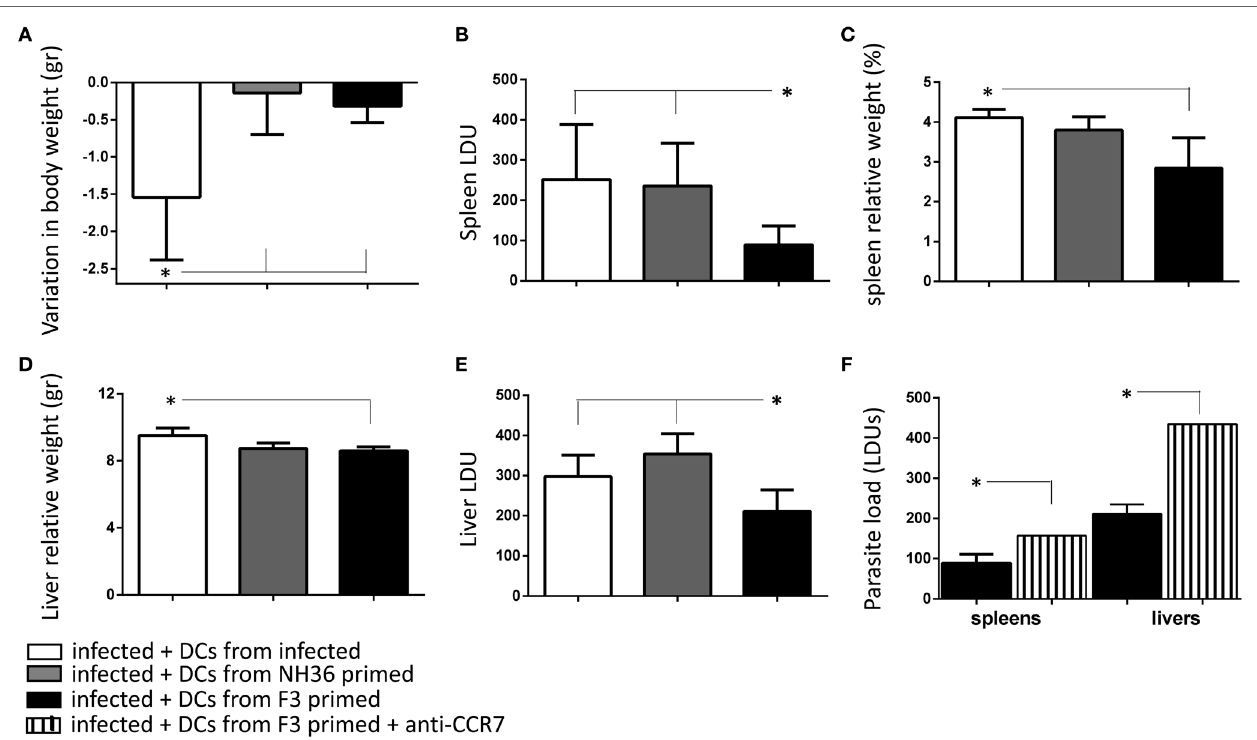
FigUre 5 | Immunotherapy with F3-primed dendritic cells (DCs) reduces parasite and clinical signs of visceral leishmaniasis. DCs (10 6 ) purified from Leishmania (L.) infantum chagasi -infected mice, or mice treated with the F3 or the NH36 vaccines and challenged, were injected into infected mice on day 28 after infection. Recipient mice were euthanized after 7 days after DC transfer and the variation in corporal weight (a) , spleen LDU (B) , spleen/body relative weight (c) , liver LDU (D) , and liver/body relative weight (e) were calculated. As a control we also showed the increase of the parasite load of spleens and livers of day 28-infected mice that received an injection of F3-primed DCs pre-incubated with anti-CCR7 antibody (F) . The results are compared with the parasite load of infected mice that received F3-primed DCs with no previous incubation. Bars represent the mean + SE values of two-independent experiments ( n = 5 mice per treatment in each experiment). Asterisks and horizontal lines show significant differences between treatments as disclosed by Mann–Whitney non-parametrical